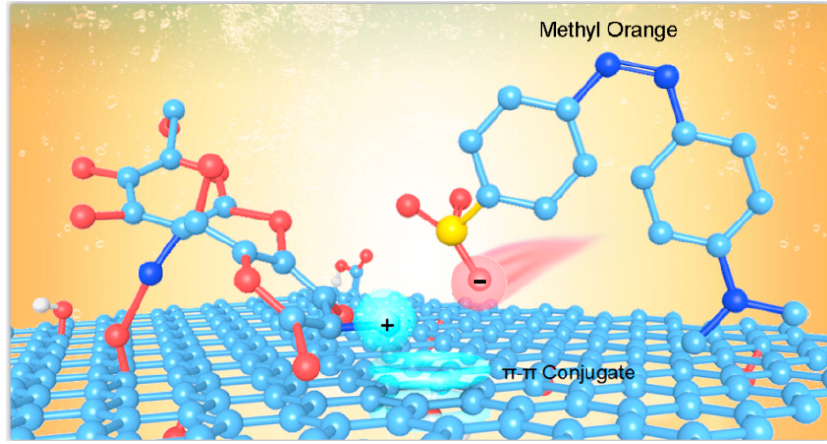
Figure 12. Schematic diagram of the adsorption of methyl orange by the CS/GO aerogel.